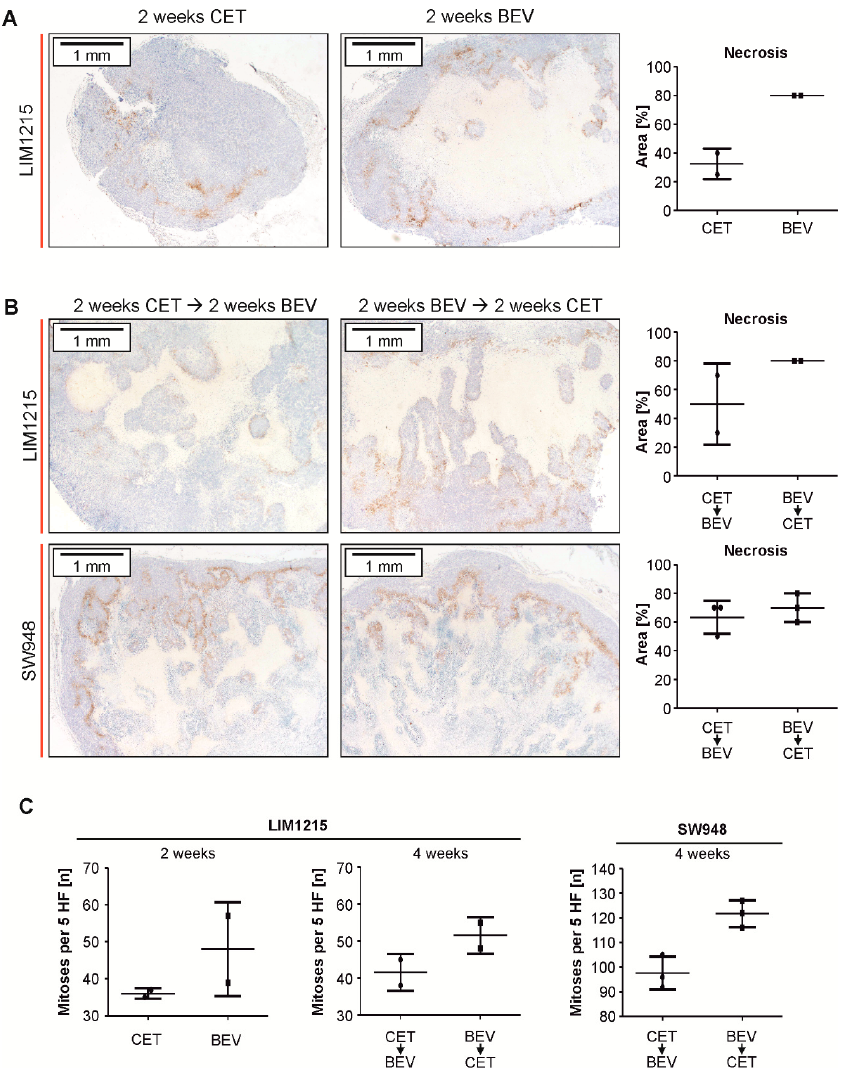
Figure 6. Analysis of experimental tumors after treatment with cetuximab (CET), bevacizumab (BEV), or both cetuximab and bevacizumab (CET->BEV and BEV->CET, respectively). ( A ) LIM1215 tumors were treated with either cetuximab or bevacizumab for two weeks and then stained for CAIX. Representative sections (left) and proportions of necrosis (right, n = 2) are depicted (formally p < 0.05, student’s t-test). ( B ) LIM1215 (upper panel) and SW948 (lower panel) tumors were sequentially treated as indicated for four weeks and then stained for CAIX. Representative sections (left) and proportions of necrosis (right, LIM1215: n = 2, SW948: n = 3) are depicted (formally p = not significant, student’s t-test). ( C ) The number of mitotic figures was counted in five consecutive high-power fields (LIM1215: n = 2, p = not significant, SW948: n = 3, p < 0.01, Student’s